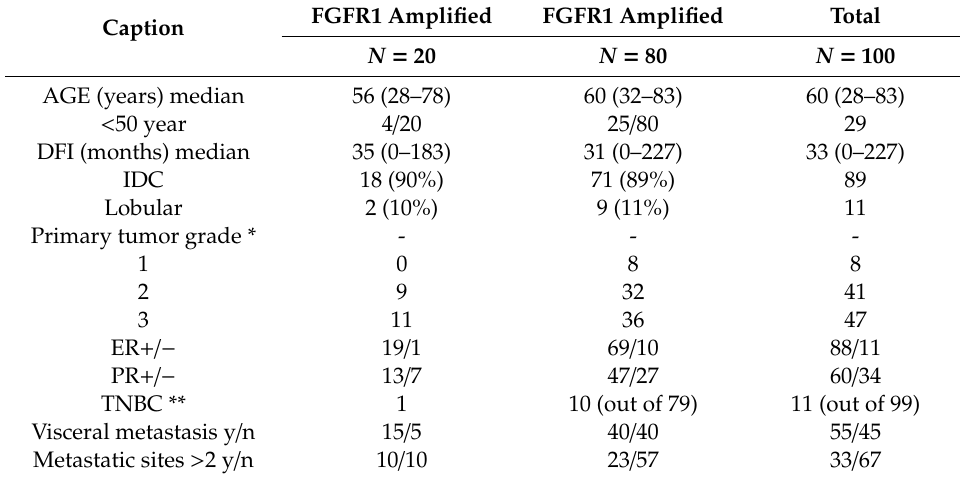
Table 1. Clinicopathological characteristics of metastatic breast cancer cohort. * 4 missing data ** 1 missing data. TNBC: triple-negative breast cancer, ER: estrogen receptor, PR: progesterone receptor, DFI: disease-free interval (between primary and distant metastasis diagnosis), IDC: invasive ductal carcinoma, FGFR1: fibroblast growth factor receptor